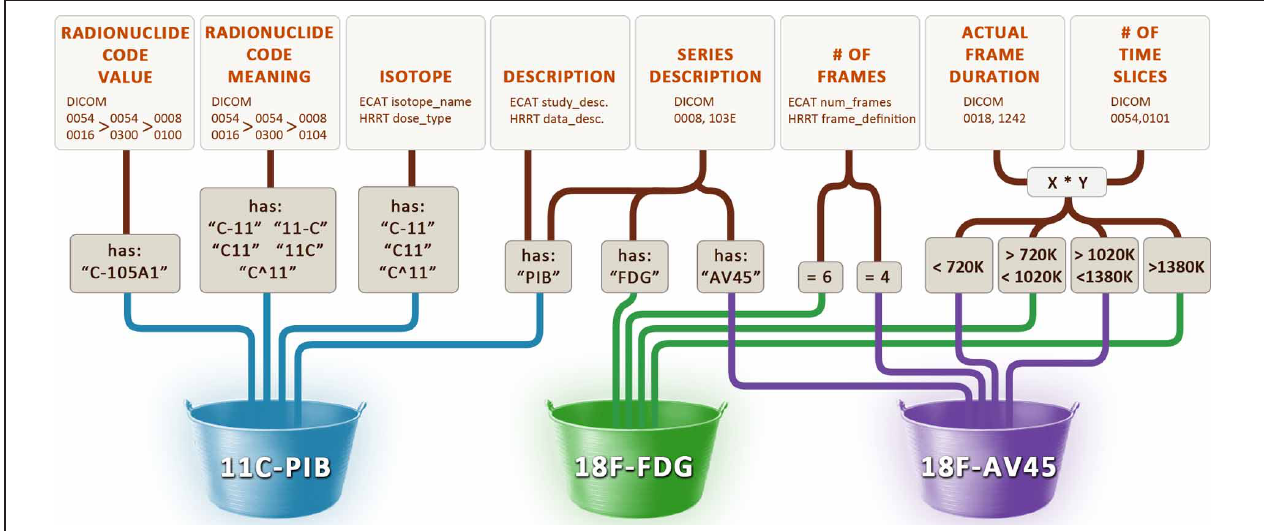
FIGURE 7 | Rules used to determine the radiopharmaceutical agent. Various image metadata fields from the DICOM, ECAT, and HRRT Interfile file formats are used to infer the name of the radiopharmaceutical agent (11C-PIB, 18F-FDG,